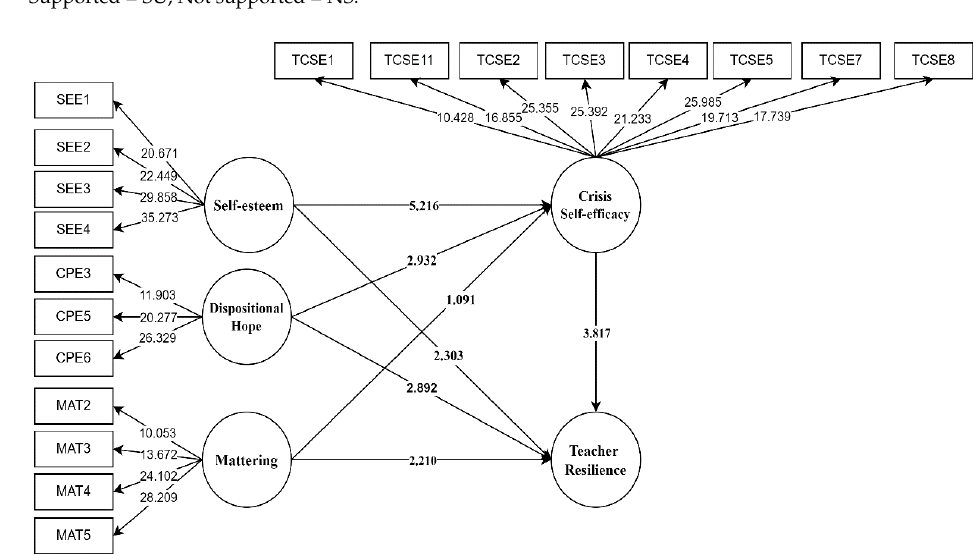
Figure 1. Diagram for the structural model of the